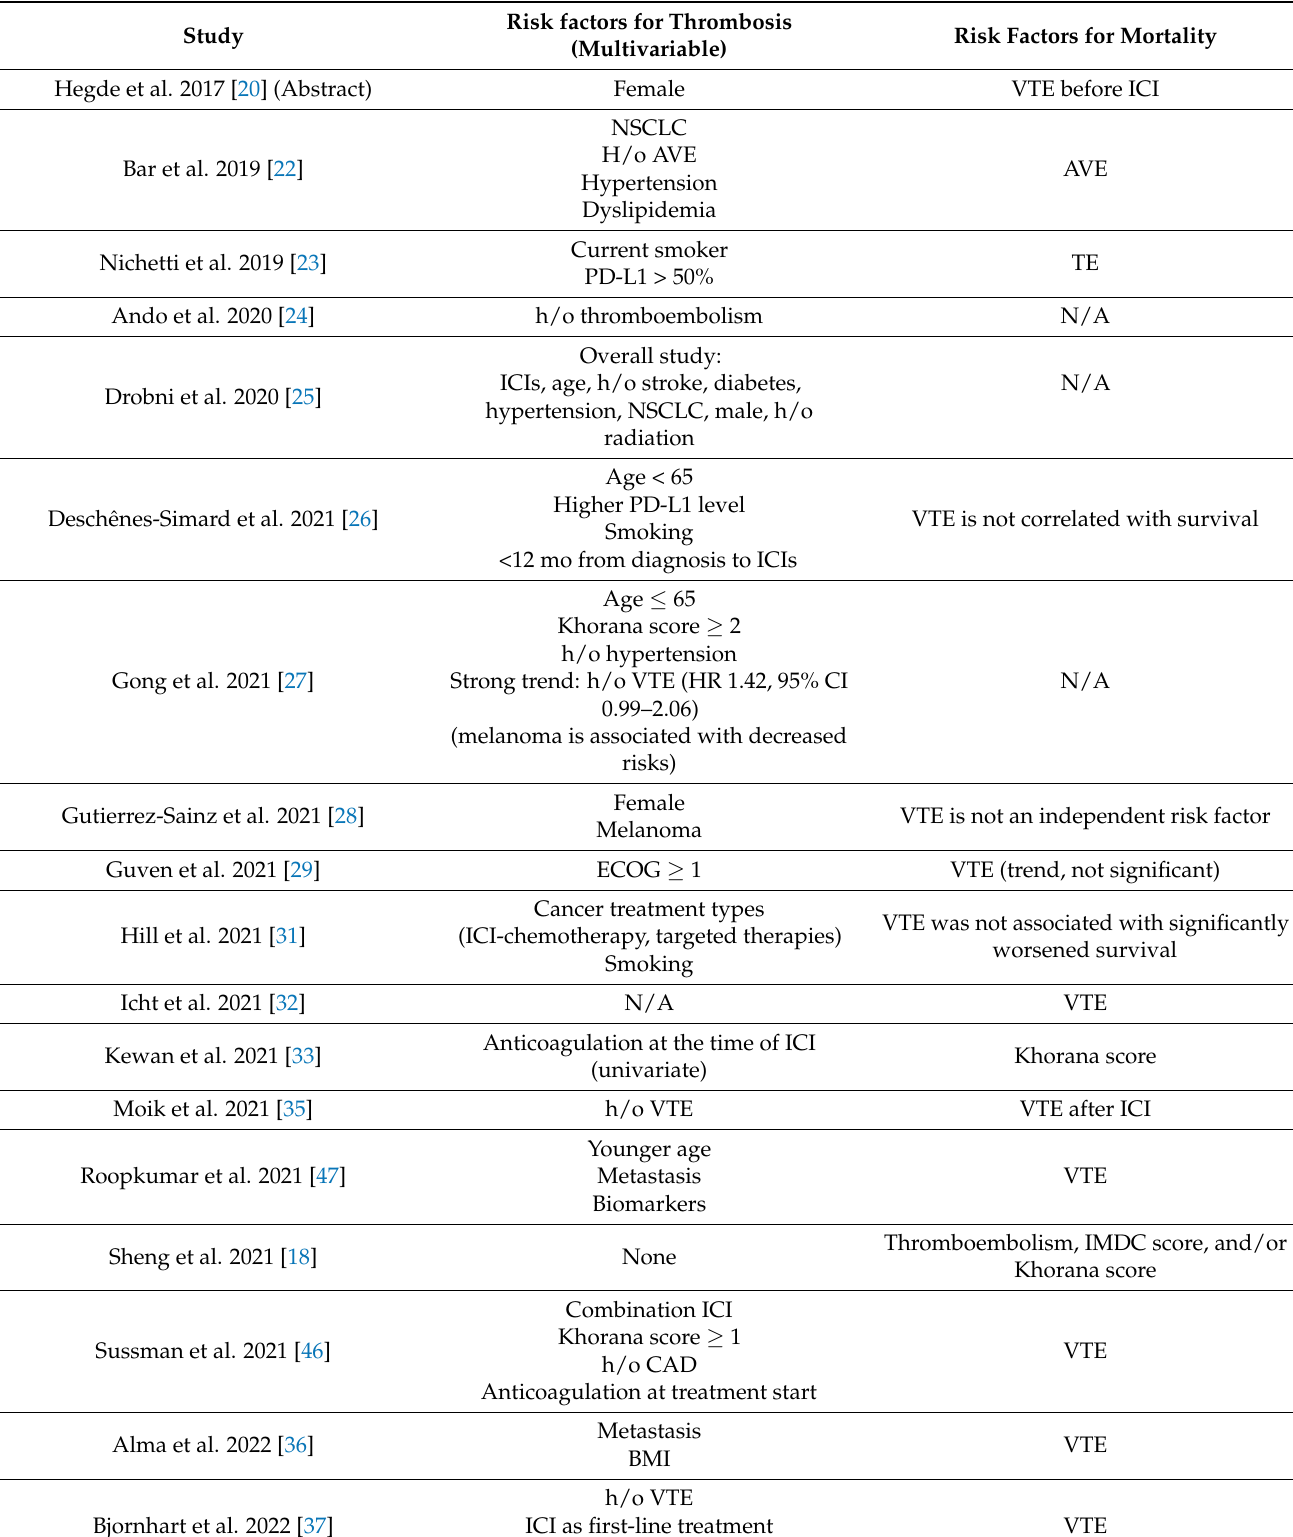
Table 4. Risk factors for thrombosis and mortality identified in patient cohorts receiving immune checkpoint